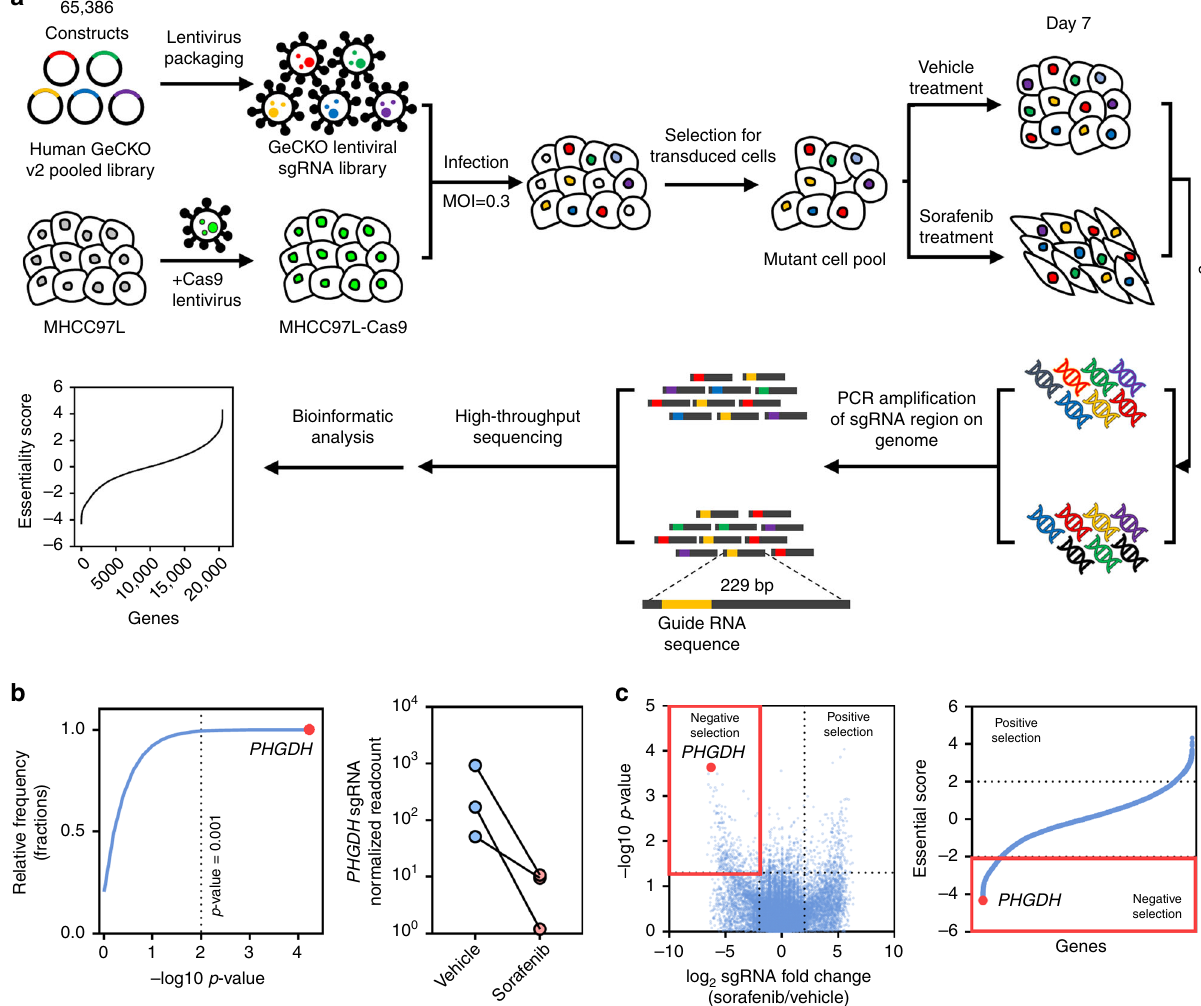
Fig. 1 CRISPR library screening identi fi ed PHGDH as a driver for Sorafenib resistance. a Schematic diagram illustrates the work fl ow of genome-wide CRISPR/Cas9 knockout library screening (CRISPR: Clustered Regularly Interspaced Short Palindromic Repeats). Human genome-wide CRISPR/Cas9 knockout library (GeCKO v2A) containing 65,386 sgRNAs was packed into lentiviral particle and transduced into Cas9-overexpressing MHCC97L cells (MHCC97L-Cas9) at low multiplicity of infection (MOI). The sgRNA transduced cells were selected by puromycin to generate a mutant cell pool. Mutant cells were cultured in vehicle and Sorafenib for 7 days for genetic screening. Genomic DNA was extracted from the treated cells and the sgRNA fragment was ampli fi ed by PCR. Copy number of sgRNAs was determined by high-throughput sequencing and analyzed by MAGeCK v0.5.7 algorithm. b PHGDH (phosphoglycerate dehydrogenase) was identi fi ed as the most signi fi cant gene in the library screening as indicated by the red dot. The sgRNAs targeting PHGDH were consistently depleted in Sorafenib-treated cells. c Volcano plots revealed that PHGDH targeting sgRNAs were negatively selected during Sorafenib treatment, suggesting that PHGDH is an essential gene for HCC cells to survive from Sorafenib treatment. Source data are provided as a Source Data fi (Fig. 1a). We hypothesized that knockout of a Sorafenib resis- were signi fi cantly depleted ( P < 0.05) in the Sorafenib-treated cells tance driver gene will sensitize HCC cells to Sorafenib-induced when compared to vehicle control, indicating that these genes cell death or proliferation suppression. In the presence of Sor- might be potential drivers for Sorafenib resistance (Fig. S1d). afenib, cells carrying sgRNA targeting Sorafenib resistance genes will be negatively selected in the mutant cell pool and their cor- responding sgRNA will also be depleted in the library that can be determined by high-throughput sequencing. We found that 7 μ M of Sorafenib treatment effectively suppressed cell proliferation (Fig. S1e) 15 . Among the list of genes, phosphoglycerate dehy- drogenase (PHGDH), the rate-limiting enzyme for SSP, was compared with the vehicle-treated group (Fig. S1b), which sug- identi fi ed as the most negatively selected gene upon Sorafenib gested an effective selection pressure. After selection, we achieved treatment. All PHGDH targeting sgRNAs were dramatically about 400× coverage of the library and around 94% of the sgRNA decreased in Sorafenib-treated cells, implying that loss of sequences were retained in all samples, which ensure the suf fi - PHGDH might sensitize HCC cells to Sorafenib treatment cient read-death and library coverage for the CRISPR library (Fig. 1b, c). In addition, we tested the effects of other genes on the screening (Fig. S1c). From this CRISPR/Cas9 knockout library top of the gene list identi fi ed by CRISPR/Cas9 knockout library screening, we identi fi ed a subset of sgRNAs targeting 984 genes